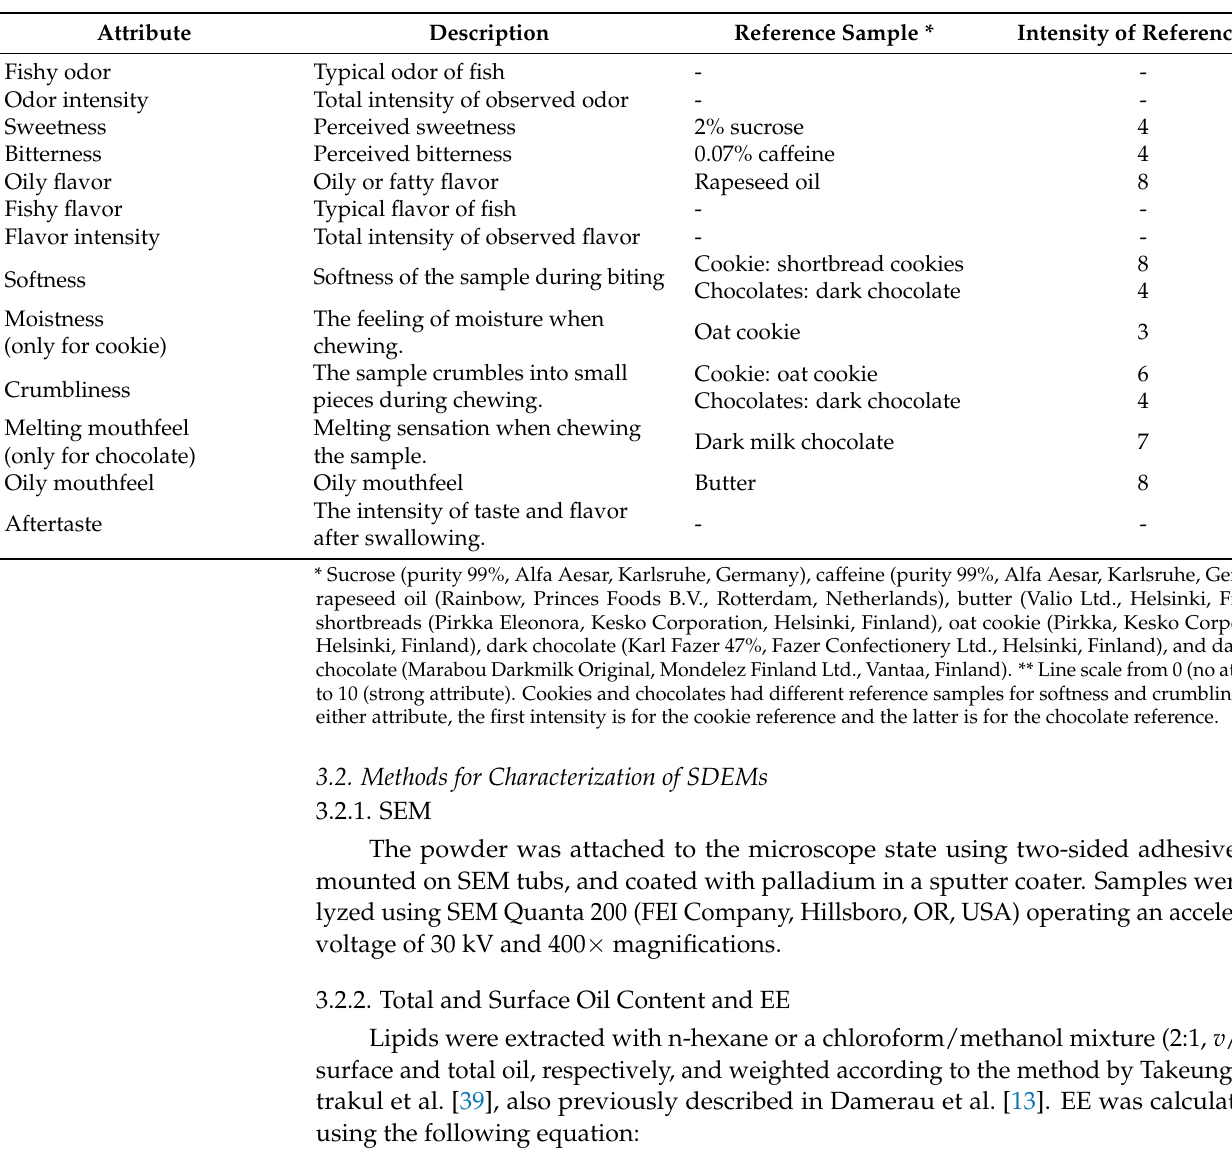
Table 5. Sensory attributes evaluated by general descriptive